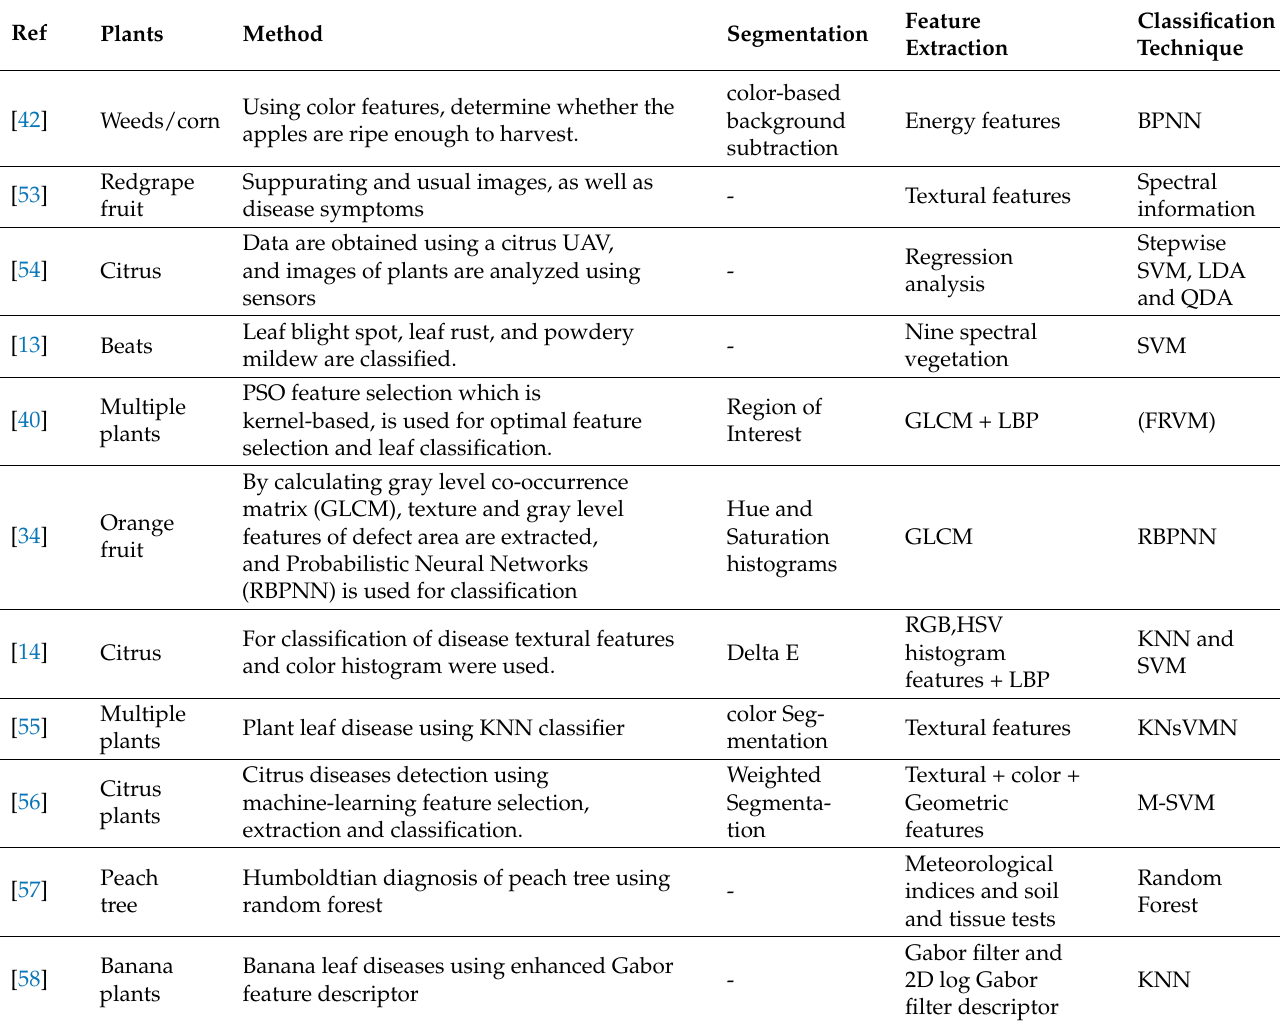
Table 1. Summary of existing methodologies on plant disease